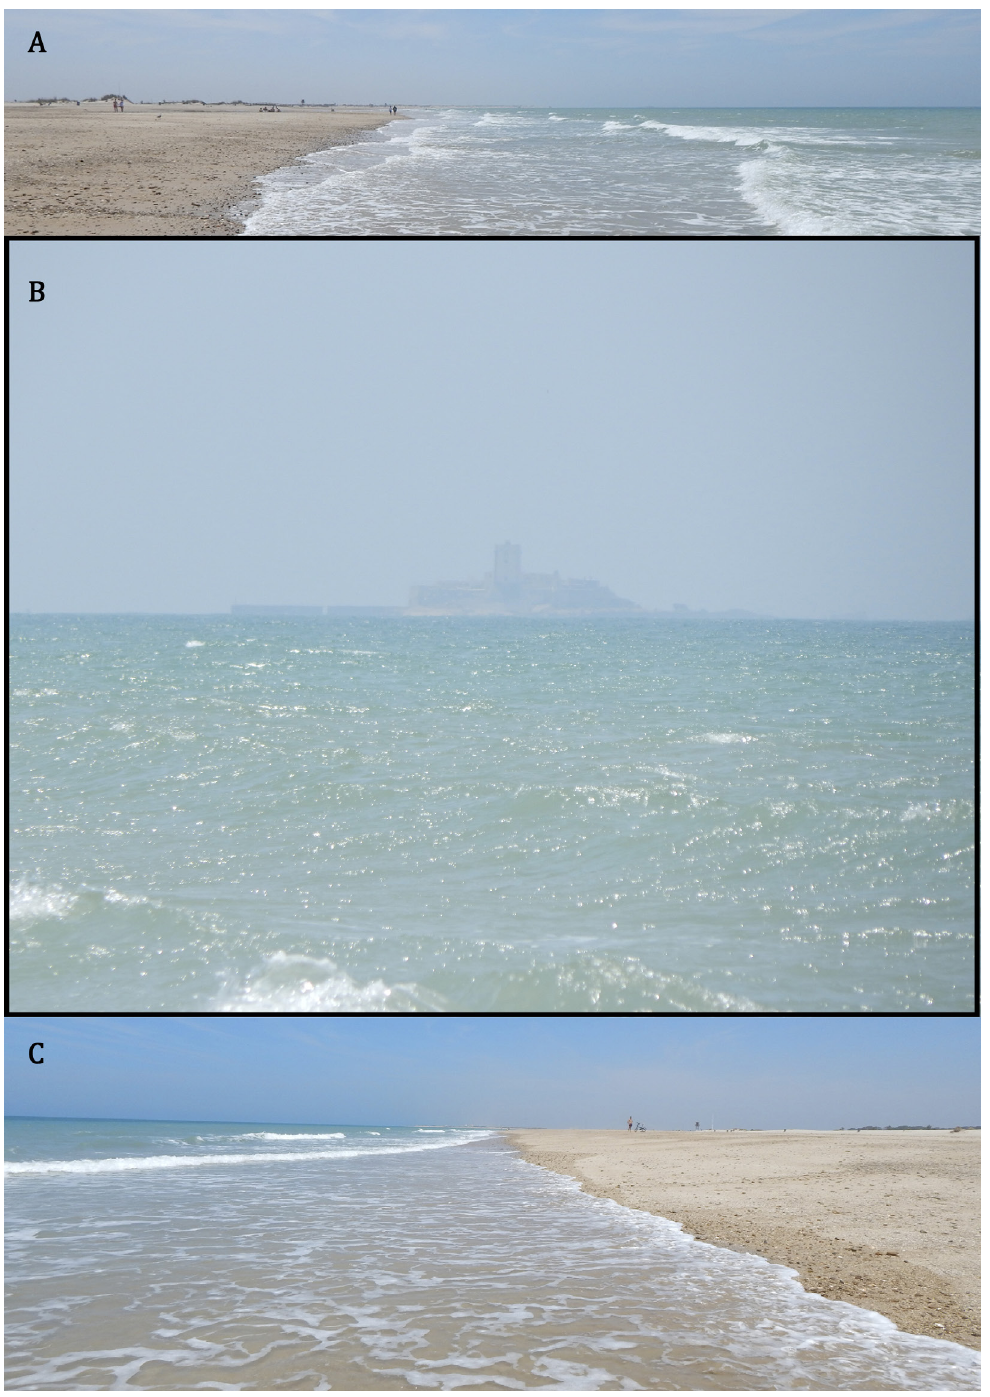
Figure 11. Study of the visibility from Camposoto-point 4. A. By facing S. Sancti Petri Castle can be observed. B. Detail of the Castle. C. Visibility towards the N. San Sebastian Castle.